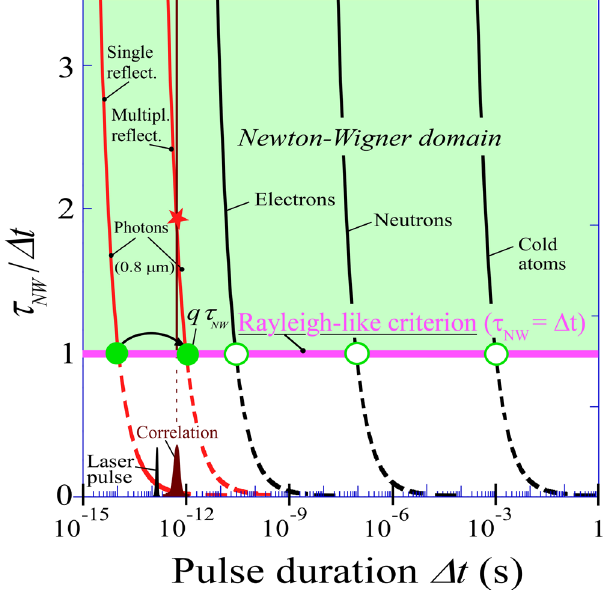
Figure 6. Comparative conditions for Newton-Wigner time delay measurements for light and different particles on interfaces. A direct measurement requires satisfying the Rayleigh-like criterion (pink line), i.e. Δ t < τ Δ t corresponds to the duration of the clock signal to be used for a given expected time delay NW , where τ NW . The corresponding working point has to be located in the so-called Newton-Wigner domain. In optics (red curves) using 150 fs laser pulses with a 300 fs correlation signals, the Rayleigh condition is not fulfilled for a single reflection, but only for multiple reflections (the filled green circles represent the experimental values for one and 161 reflections). For particles (black curves), for which correlations are no more necessary, longer pulse durations are sufficient to reach the expected delays (open green